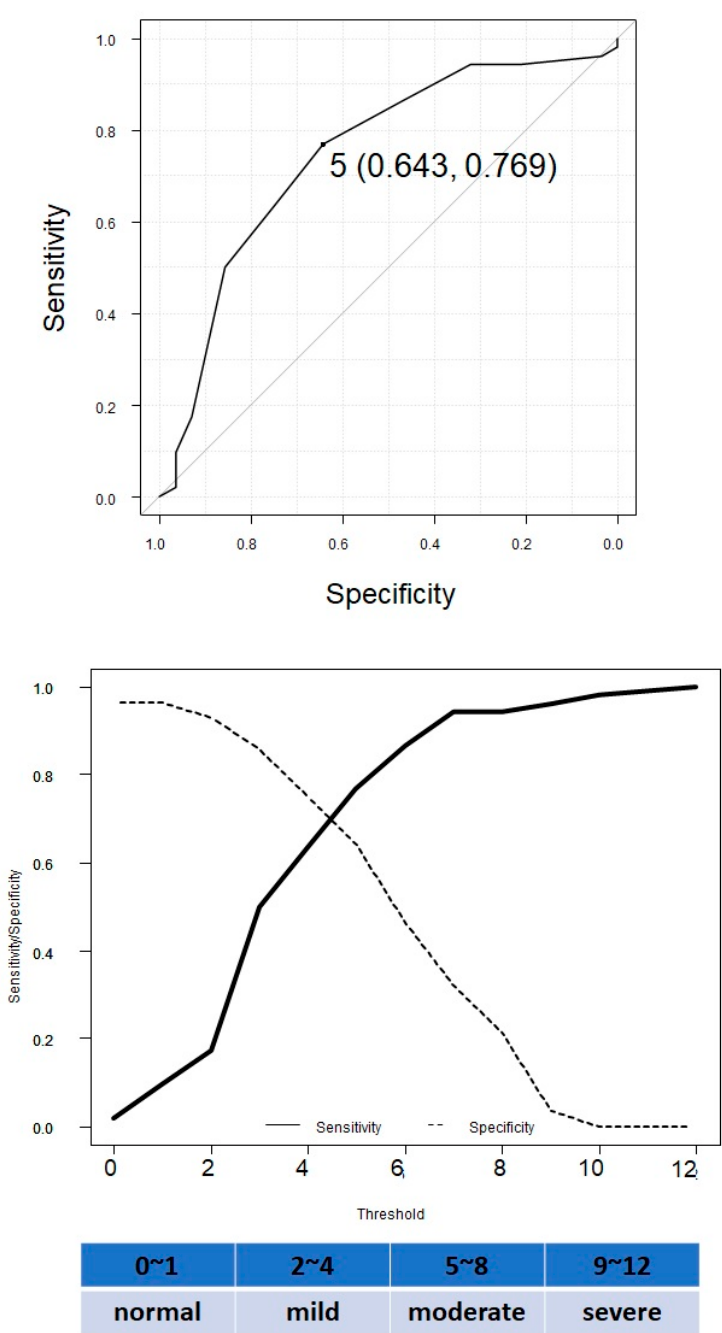
Figure 4. A receiver-operating characteristic (ROC) curve analysis to determine the cut-off levels of the controlling nutritional status (CONUT) score to distinguish between the presence and absence of major adverse limb event (MALE).